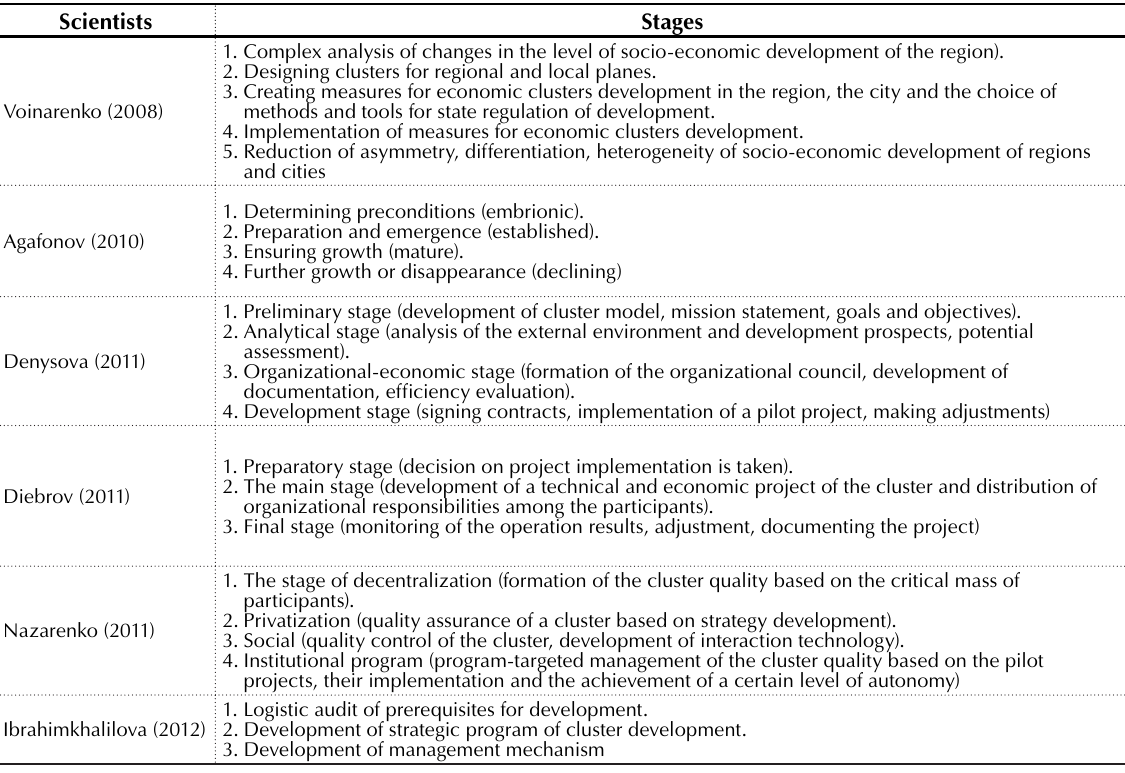
Table 1 (cont.). Grouping scientific views of stages of cluster formation and